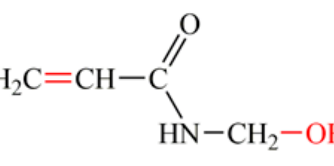
Figure 2. Structural formula of N -methylolacrylamide.